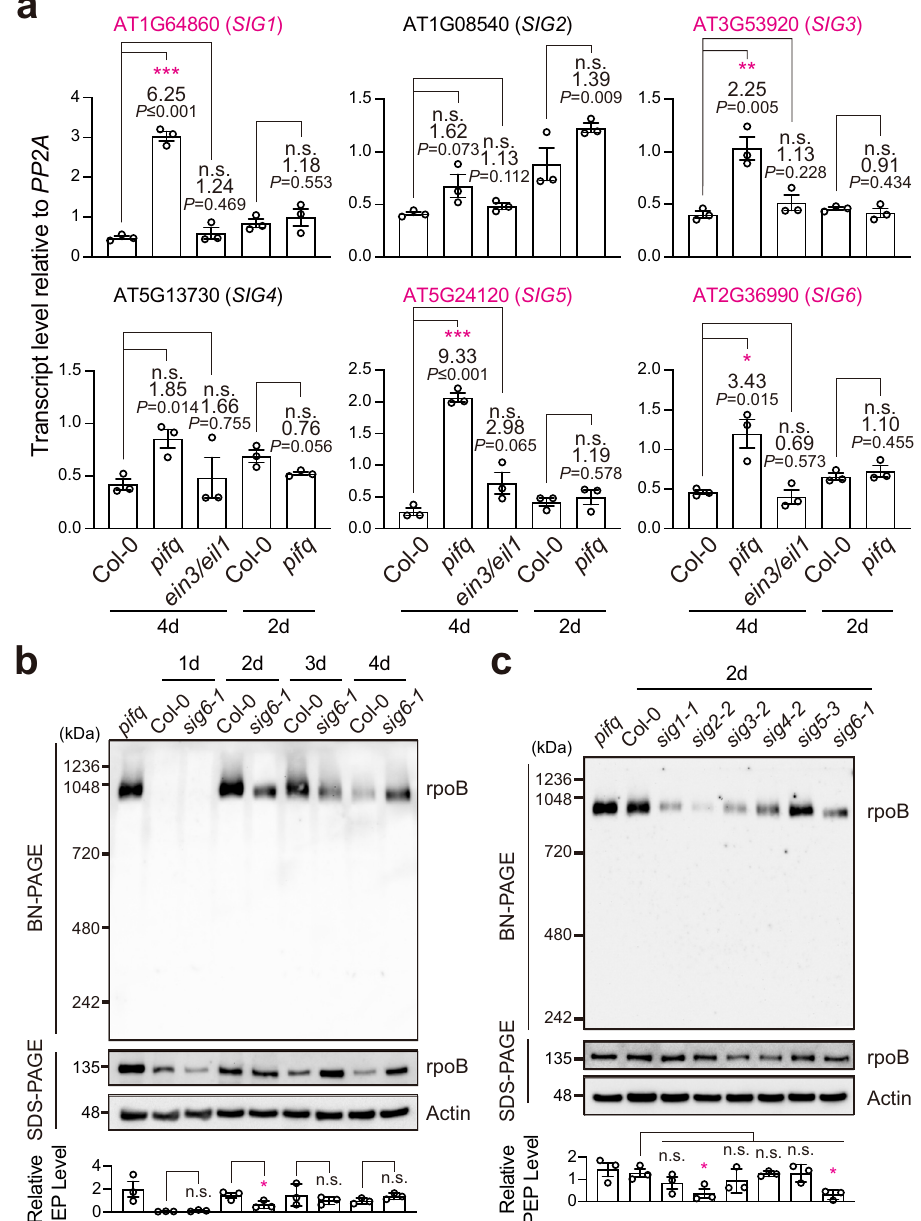
Fig. 7 | PEP activation correlates with the expression of PIF-repressed sigma factors. a qRT-PCR analysis of the steady-state transcript levels of SIG1-6 in dark- grown 4-d-oldCol-0, pifq , and ein3/eil1 , aswell as 2-d-oldCol-0 and pifq seedlings. The transcript levels were calculated relative to those of PP2A . The fold changes betweenthetranscriptlevelsinthemutantsandtheirrespectiveCol-0controlsare shown. Asterisks indicate statistically signi fi cant differences in the transcript level compared with that of Col-0 based on two-tailed Student ’ s t -test ( * P ≤ 0.05, ** P ≤ 0.01, *** P ≤ 0.001). If the change was less than two-fold or not statistically sig- ni fi cant, it is labeled as n.s. (not signi fi cant). Error bars represent the s.e. of three biological replicates, and the centers of the error bars represent the mean values. b Immunoblots showing the levels of the PEP complex and the core PEP compo- nent rpoB in Col-0, and sig6-1 seedlings grown in 10 μ molm − 2 sec − 1 R light for 1 to 4days after imbibition. c Immunoblots showing the levels of the PEPcomplexand the core PEP component rpoB in 2-d-old Col-0, sig1-1 , sig2-2 , s ig3-2 , sig4-2 , sig5-3 ,